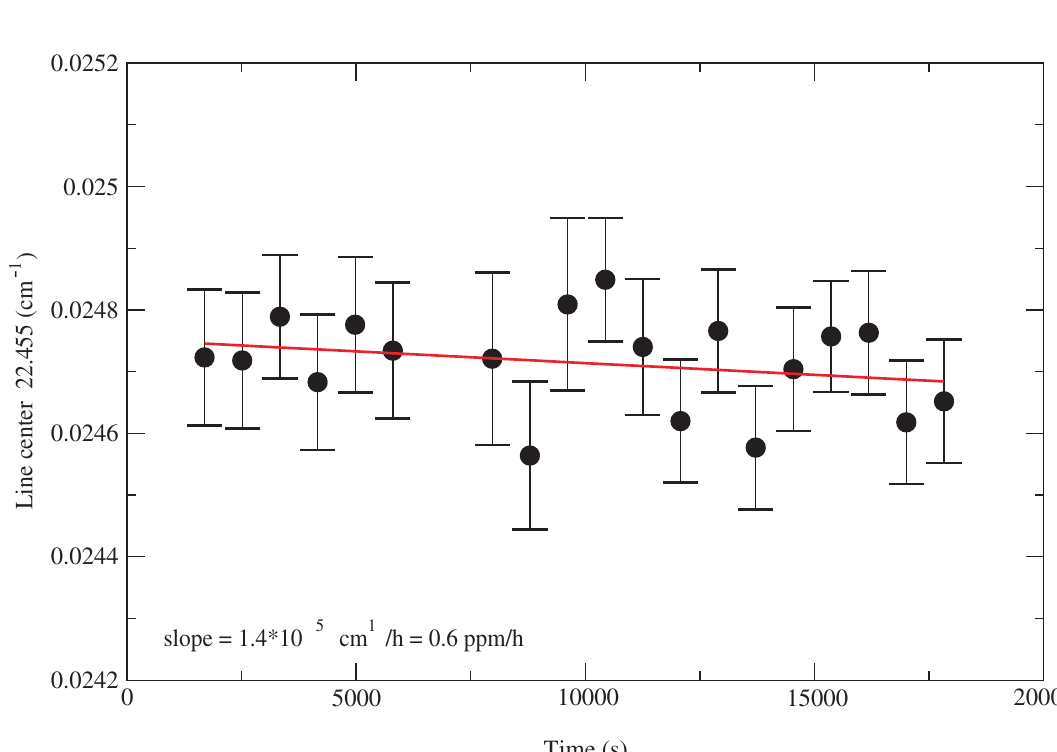
Fig. 11. Frequency stability of the SAFIRE-A laser reference system (fl ight